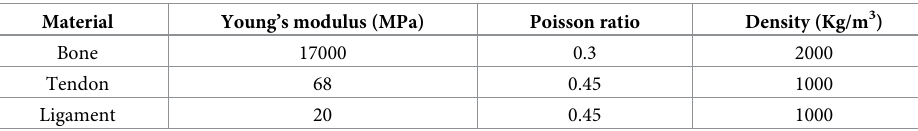
Table 4. The determined values of material